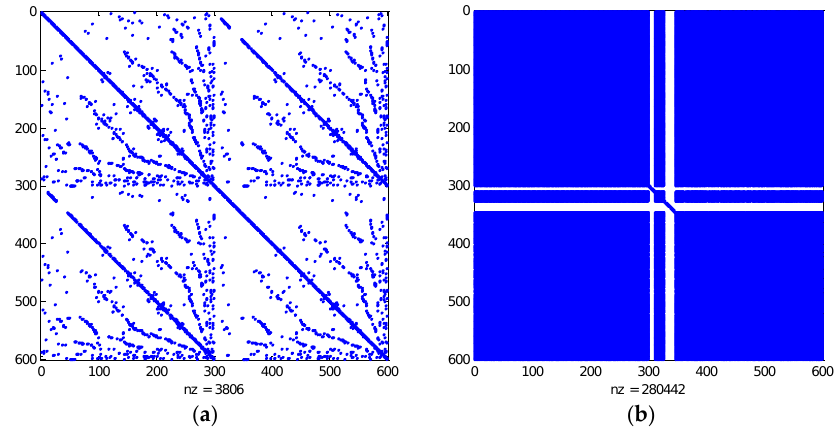
Figure 6. The sparseness of the Jacobian matrix and its inverse of IEEE-300 systems. ( a ) the Jacobian matrix; ( b ) the inverse of the Jacobian matrix.